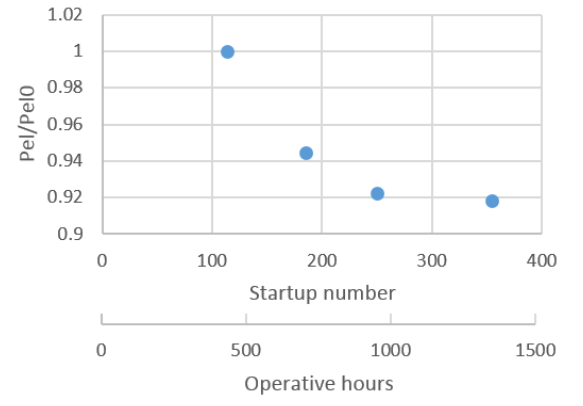
Figure 6. Maximum electrical power as a function of the number of